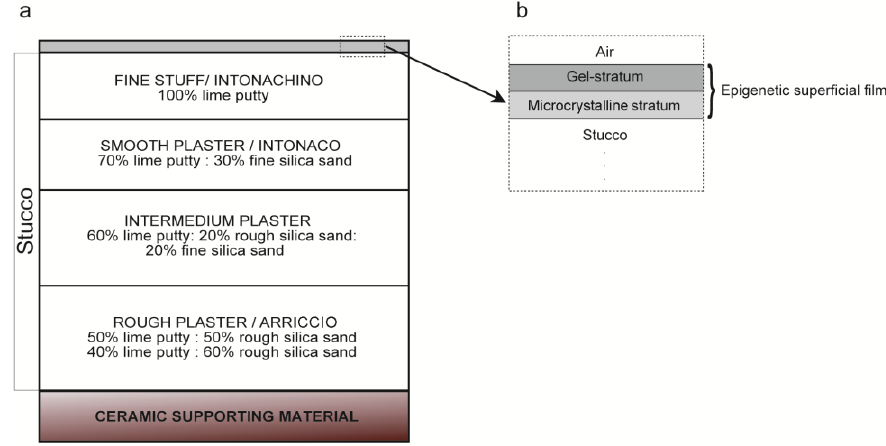
Figure 1. ( a ) Stratigraphy of a typical stucco test tube. The square denotes the area enlarged in ( b )